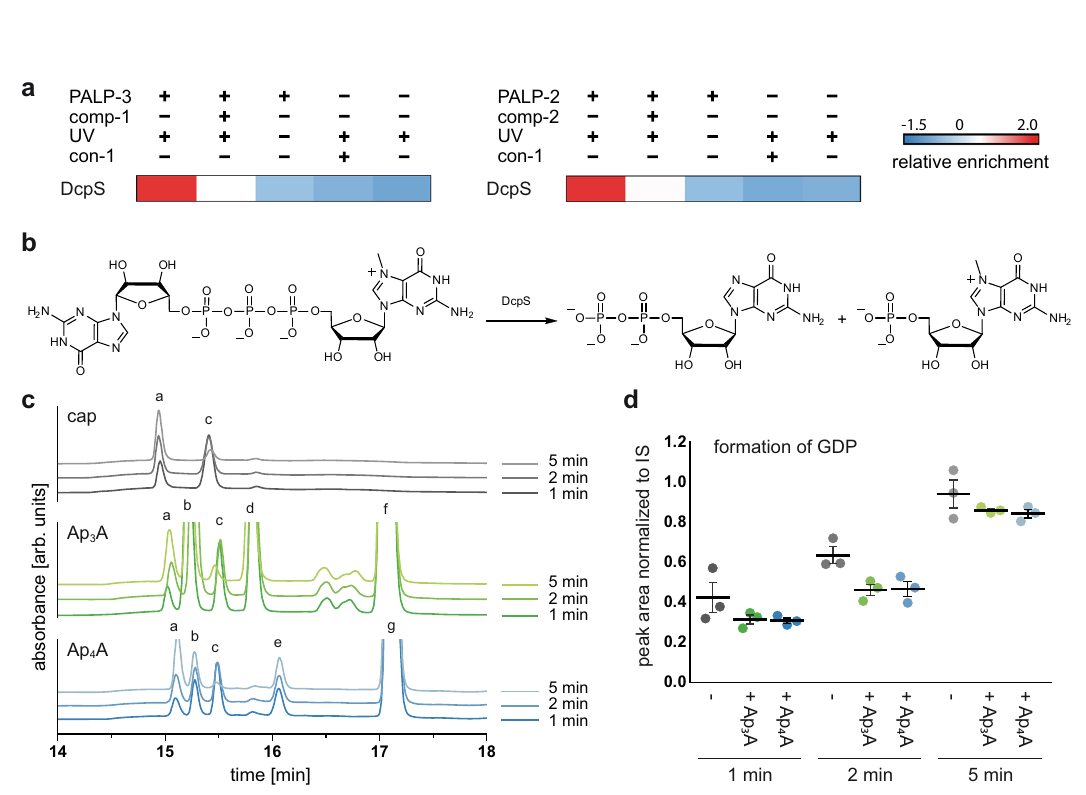
Fig. 4 Investigation of the interaction of Ap n As with DcpS. a Extract of ANOVA-heatmap ( Z -scores) for DcpS under different PAL conditions. b DcpS catalyzed cleavage of m 7 Gp 3 G. c Excerpt of the HPLC pro fi les for the hydrolysis of m 7 Gp 3 G (peak c) catalyzed by DcpS. The initial substrate concentration was 20 µ M and the reactions were carried out in the absence (gray) or presence of Ap 3 A (green) and Ap 4 A (blue) (200 µ M) at an enzyme concentration of 100 n M . Absorbance was measured at 260 nm (arb. units, arbitrary units). Formation of GDP (peak a) can be observed for all reactions. For Ap 3 A (peak f), ADP (peak b) and AMP (peak d) were identi fi ed as hydrolysis products. By analogy, AMP (peak d) and ATP (peak e) were identi fi ed as the cleavage products of Ap 4 A (peak g). The chromatographic peaks were identi fi ed by comparison with the retention times of reference samples and by subsequent MS analysis. d Quanti fi cation of the cleavage product GDP at different time points, applying adenosine as internal standard (IS). Data presented are mean ± SEM, n = 3 biologically independent experiments. Source data are provided as a Source Data fi